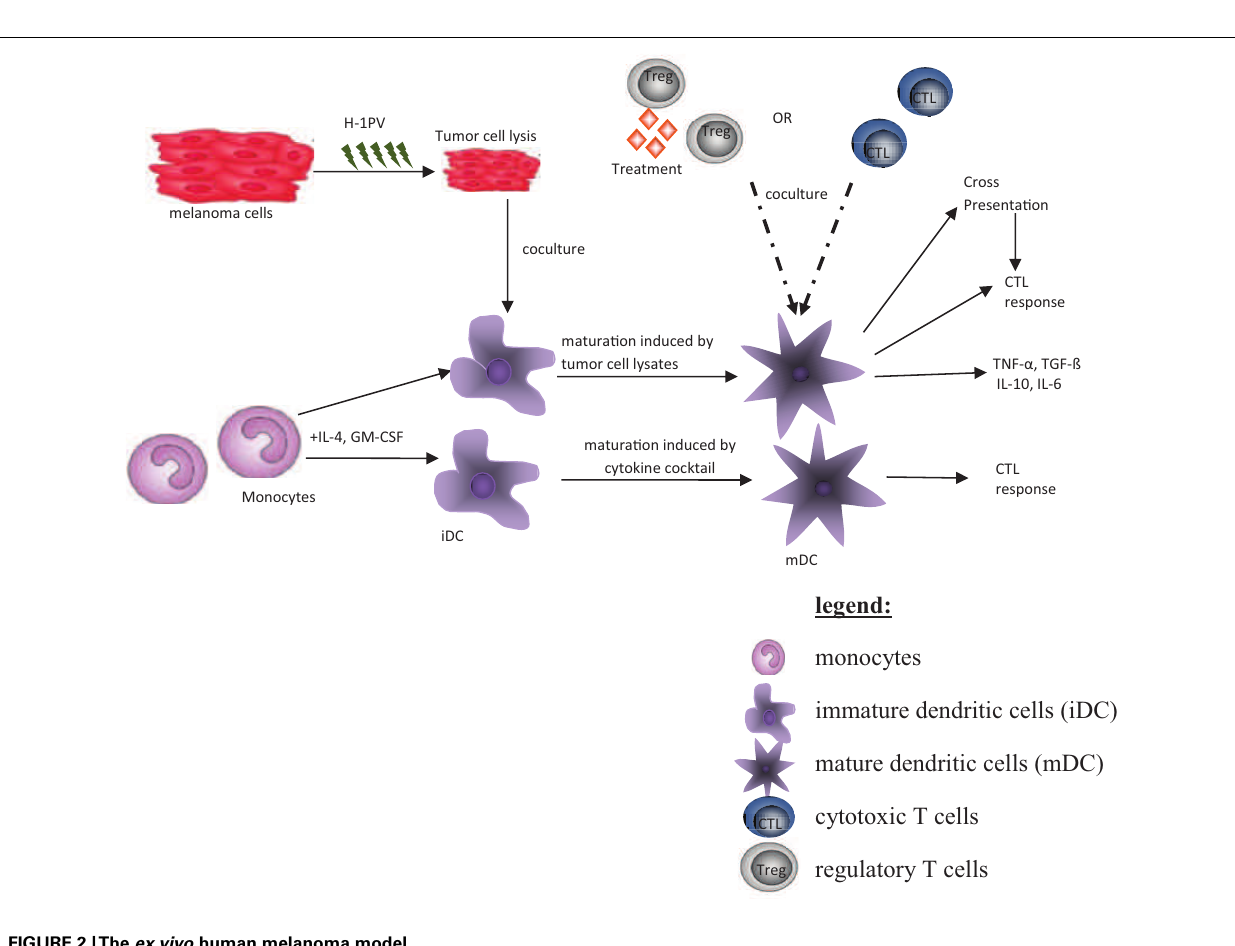
FIGURE 1 | Oncolytic viruses and their possible function in tumor therapy [changed after Ref. (14)] .